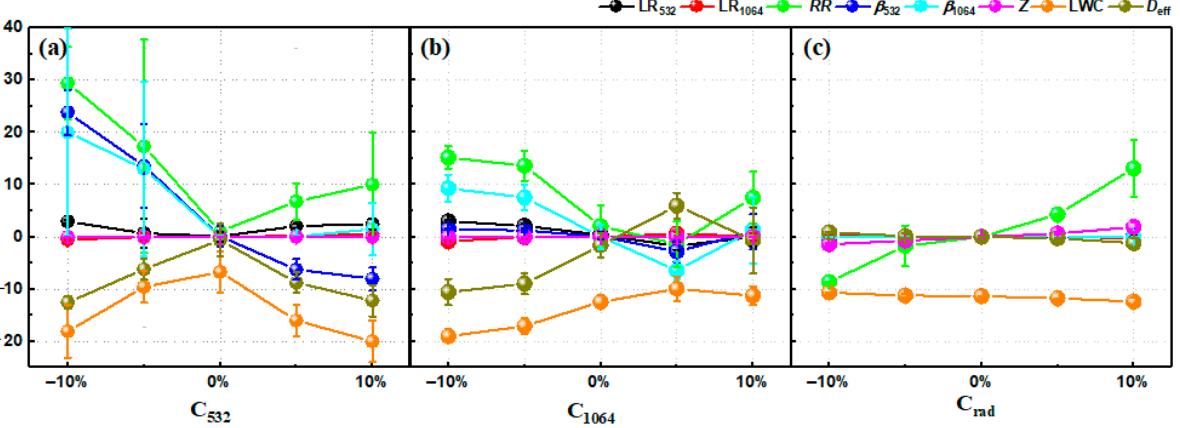
Figure 5. Results for the relative error with changes in the initial parameters: ( a ) lidar constant at 532 nm ( C 532 ); ( b ) lidar constant at 1064 nm ( C 1064 ); ( c ) radar constant ( C rad ).